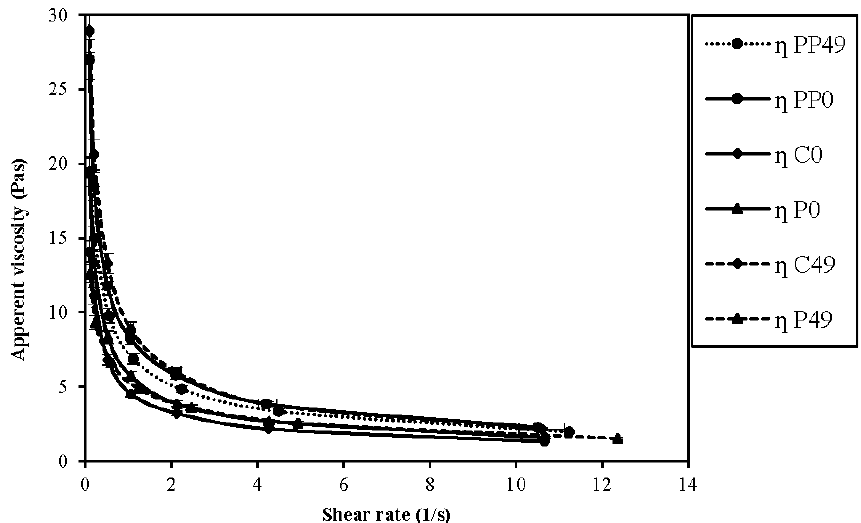
Figure 3. Plots of changes of apparent viscosity with the rising shear rate for the production date and expiration